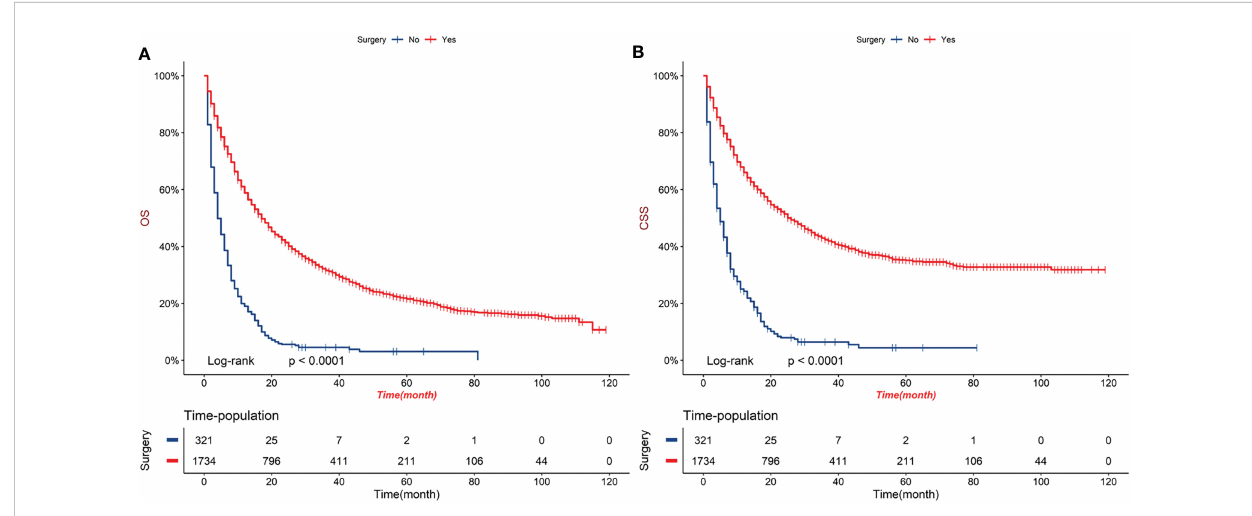
FIGURE 2 Kaplan-Meier curves of OS (A) and CSS (B) of order GBC patients before